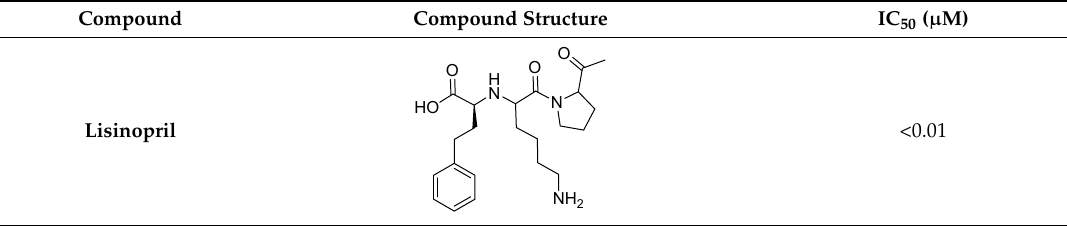
Table 1. ACE-inhibitory activity of each newly synthesized compound (IC 50 values in µ M).